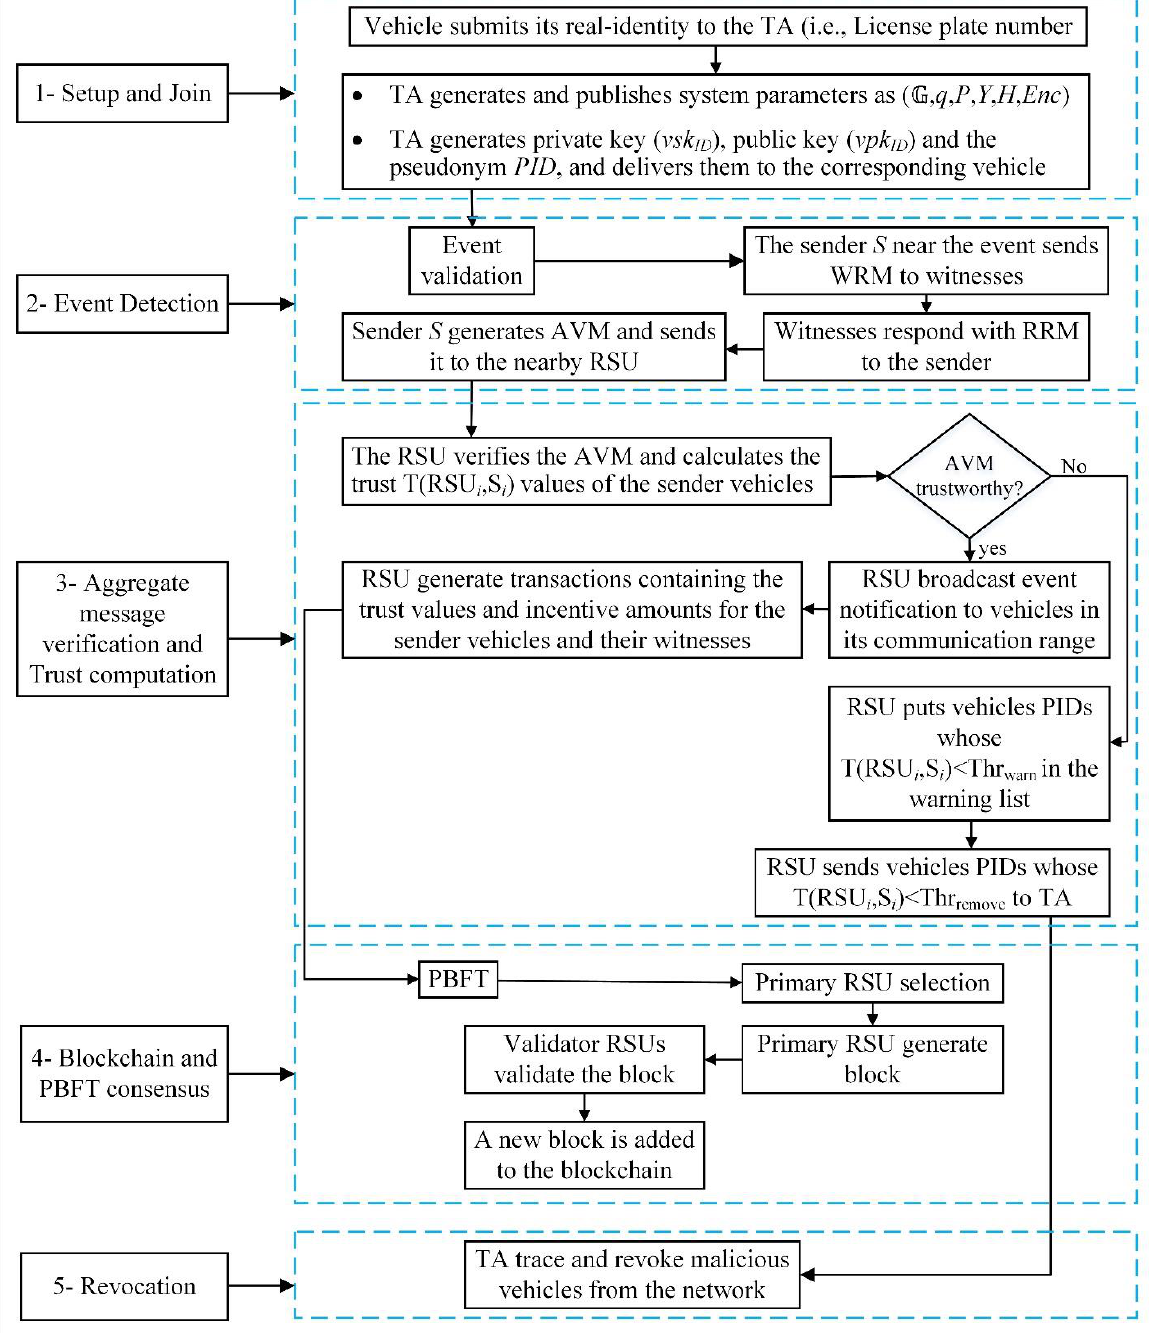
Figure 3. The framework of the proposed